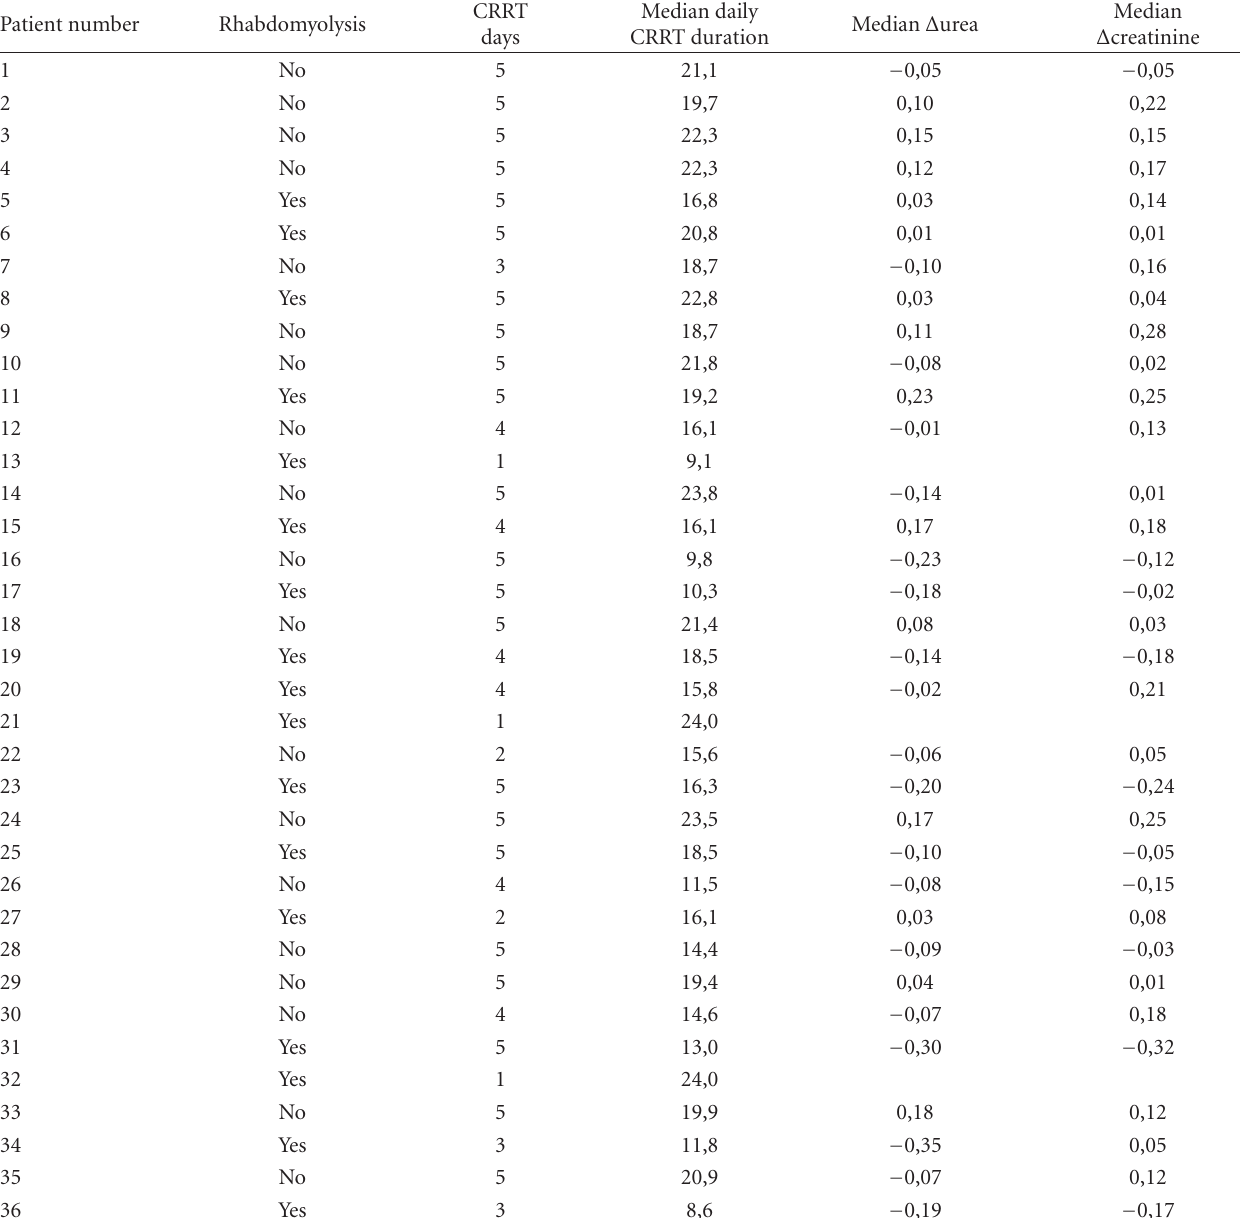
Table 2: Individual data: Trauma patients with acute kidney injury with continuous renal replacement therapy (CRRT) grouped with and without rhabdomyolysis ( n =